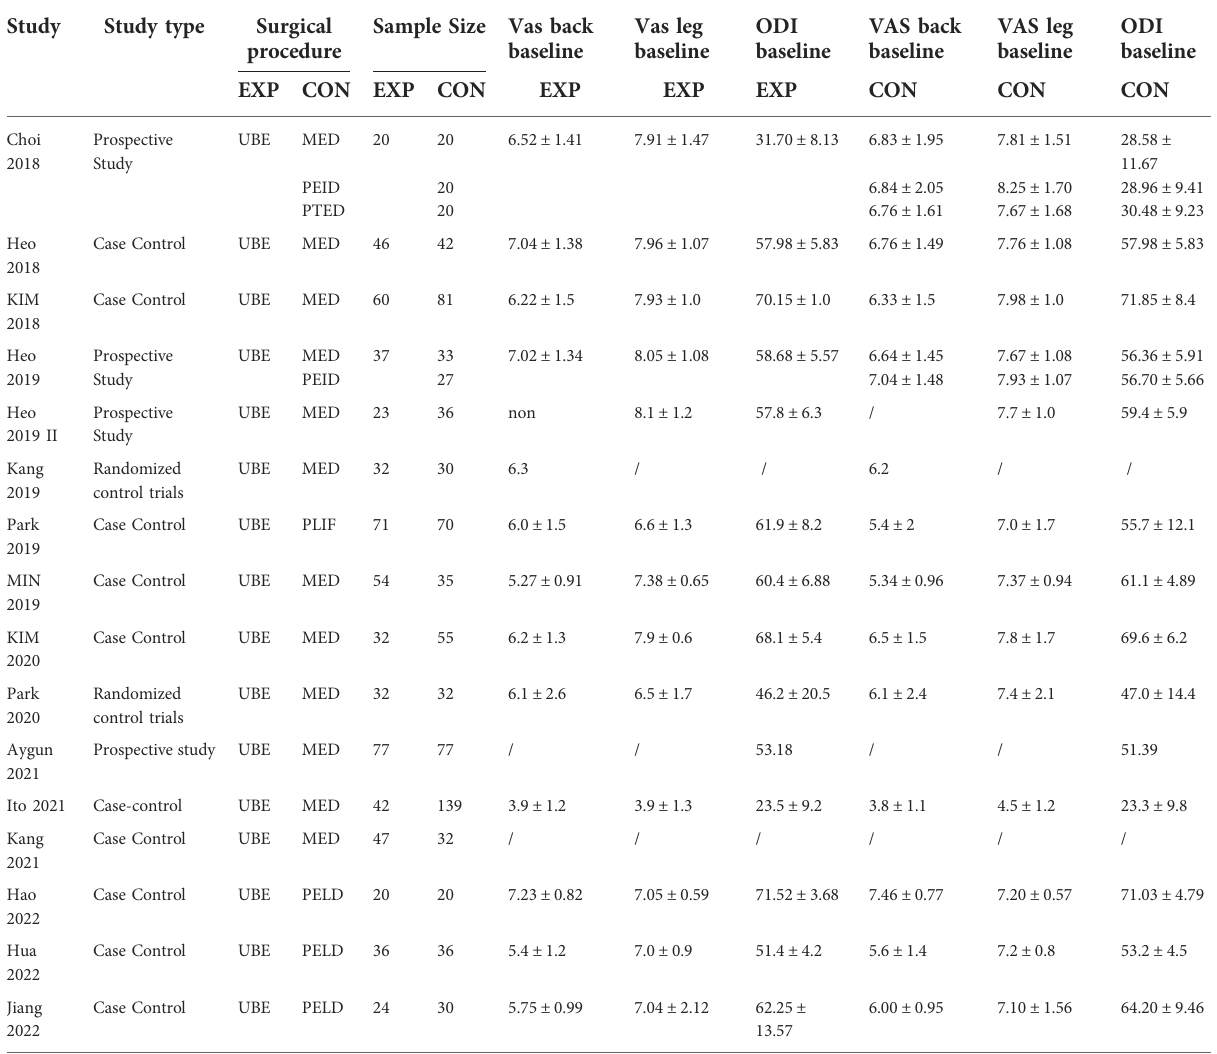
TABLE 1 Included studies